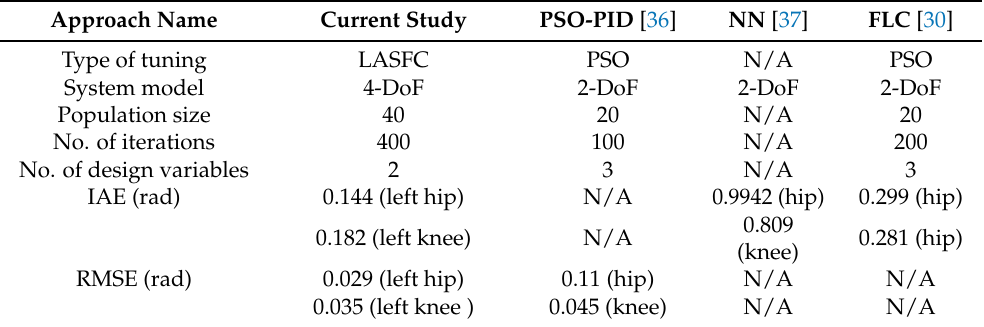
Table 7. Comparison of LASFC performance with other control strategies for